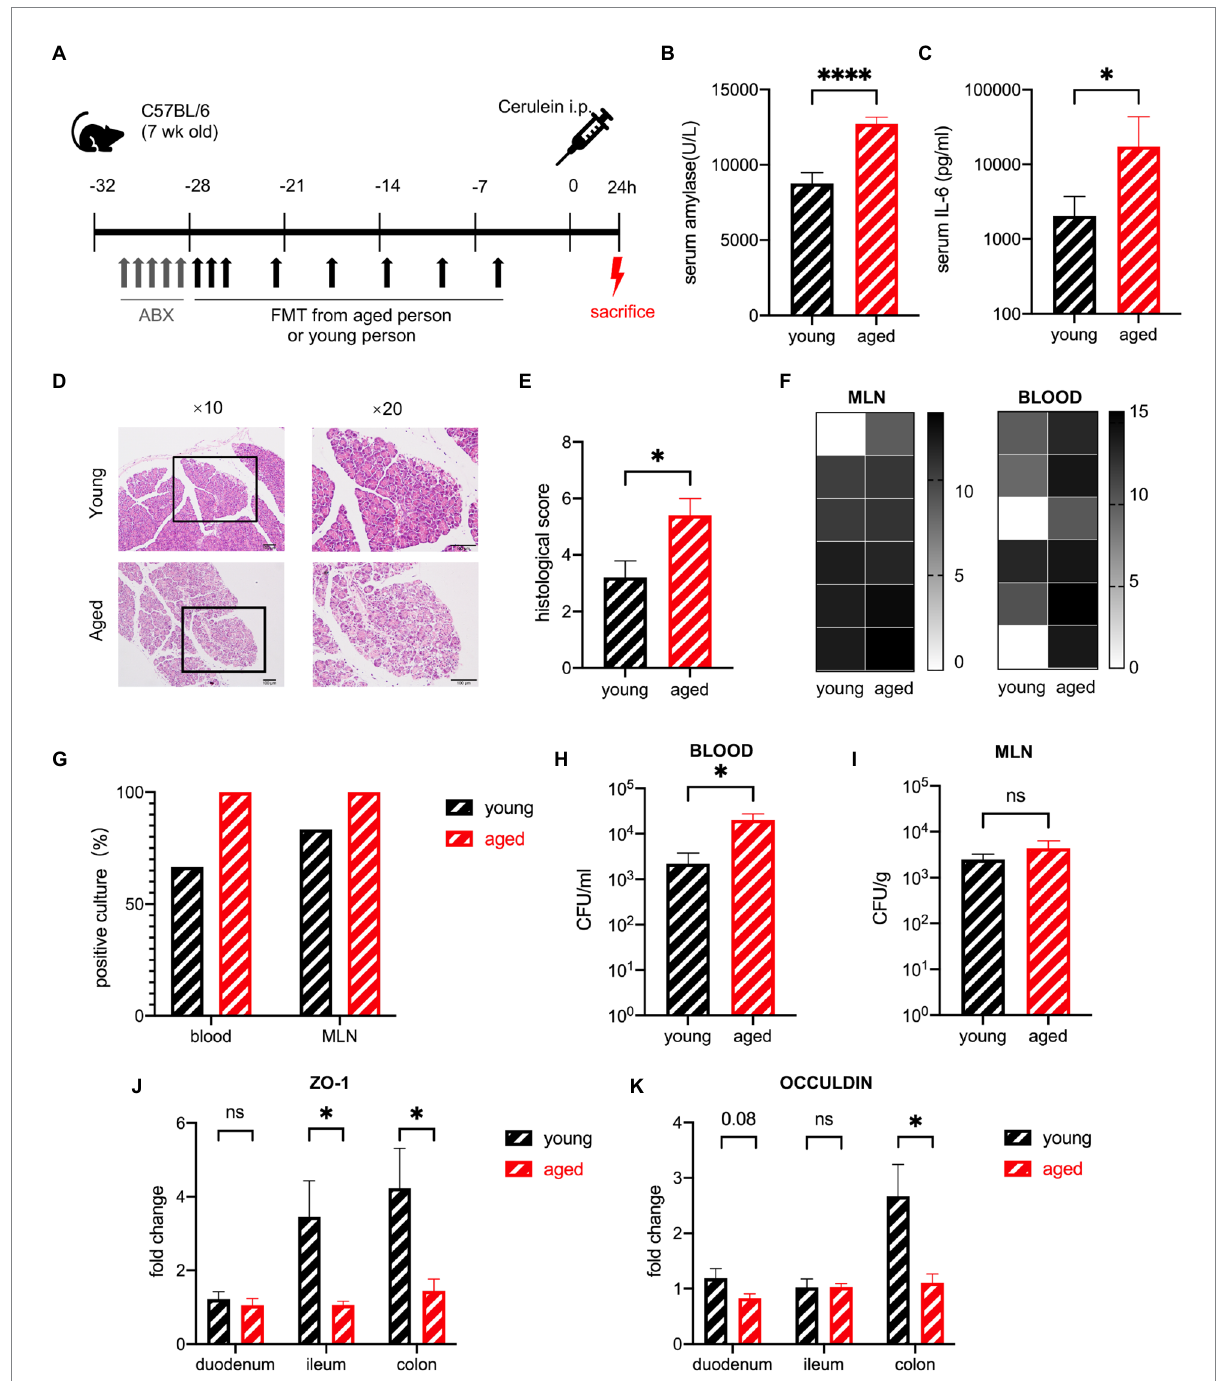
FIGURE 3 Gut microbiota of healthy older people increase the severity of SAP in mice in the early stage. (A) Mouse model of severe acute pancreatitis. (B) Serum amylase levels are significantly increased in the old group ( n = 19) compared to the young group ( n = 16). (C) Serum IL-6 levels are significantly increased in the old group ( n = 14) compared to the young group ( n = 12). (D) Representative hematoxylin and eosin staining of pancreatic tissue. (E) Histopathological scoring of pancreatic damage ( n = 5 per group). (F) Heatmap of the CFU (log2) of blood and MLN ( n = 6 per group). (G) Frequency of culture positivity in blood and MLN ( n = 6 per group). CFU ( n = 6 per group) in the blood (H) and MLN (I) . (J) Expression of tight junction genes ZO-1 in the duodenum, ileum, and colon of the young group ( n = 5) versus the old group ( n = 5). (K) Expression of tight junction genes OCCULDIN in the duodenum, ileum, and colon of the young group ( n = 5) versus the old group ( n = 5). * p < 0.05, ** p < 0.01, *** p < 0.001, **** p < 0.0001, ns, no significant